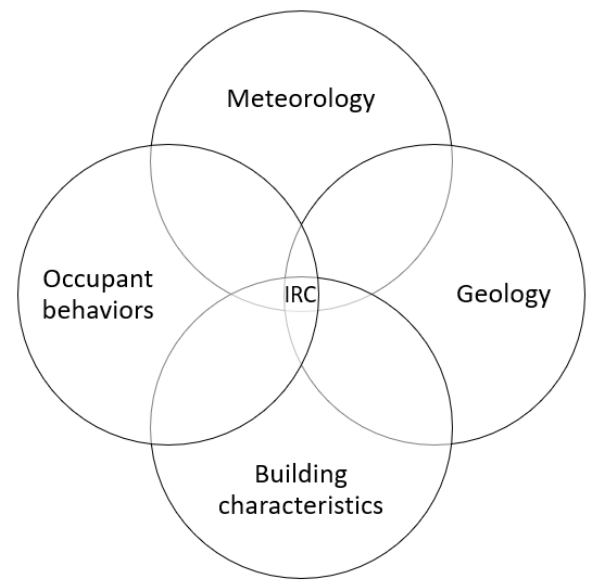
Figure 1. IRC is directly influenced by local geology, occupant behaviours, building characteristics, and meteorology—the latter aspect being the main focus of this study. Others influences on IRC cannot be specifically identified, but cannot be